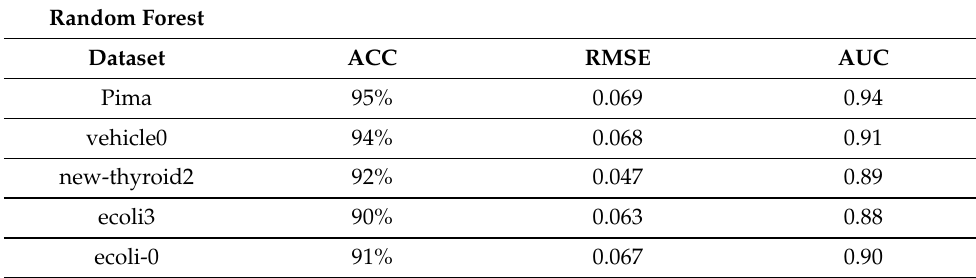
Table 3. Evaluation results for the proposed algorithm to handle the imbalanced class problem— random